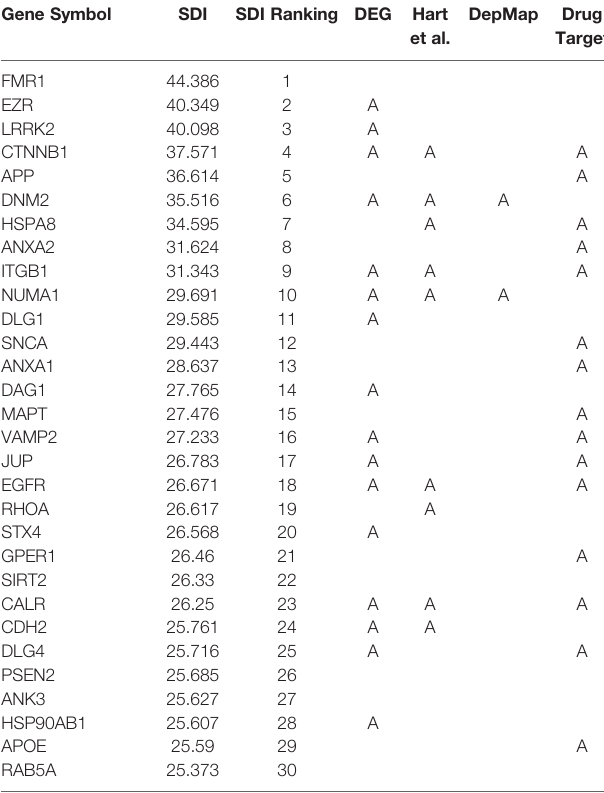
TABLE 2 | Top 30 human genes with the highest SDI scores. Gene Symbol SDI SDI Ranking DEG Hart